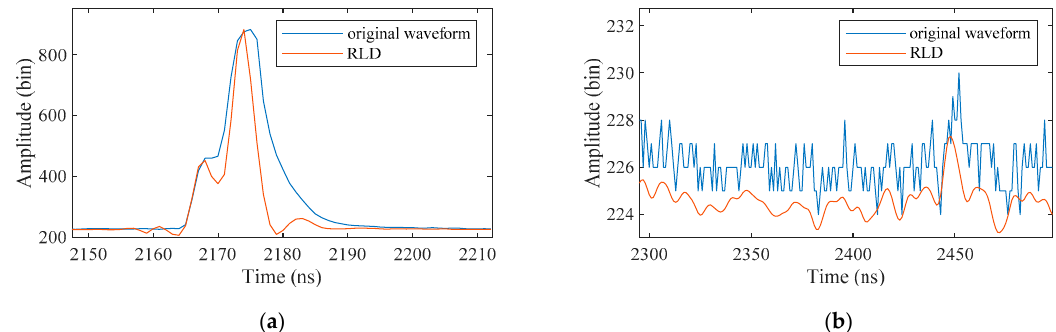
Figure 6. Examples of the deconvoluted waveforms by RLD in ( a ) shallow water and ( b ) deep water. RLD: Richardson–Lucy Deconvolution. The result of the deep water waveform is only displayed in the portion near the bottom signal.